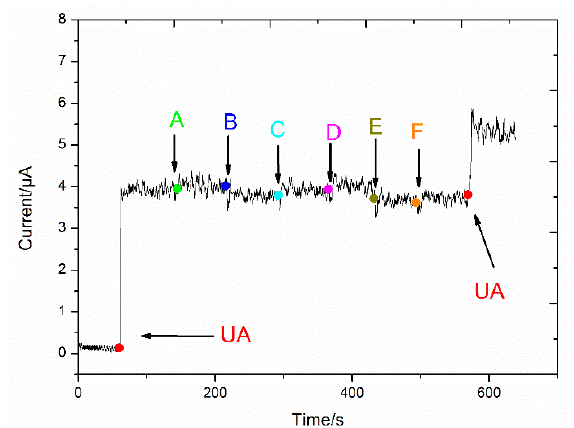
Figure 5. Interference experiments of UOx/BSA/BLG-MWCNTs-PtNPs/GCE in pH 7.0 0.1 M PBS solution containing UA or other substances: ( A ) dopamine (0.1 mM), ( B ) glutathione (0.2 mM), ( C ) Table 2. Recovery ratios of uric acid in 20% serum.